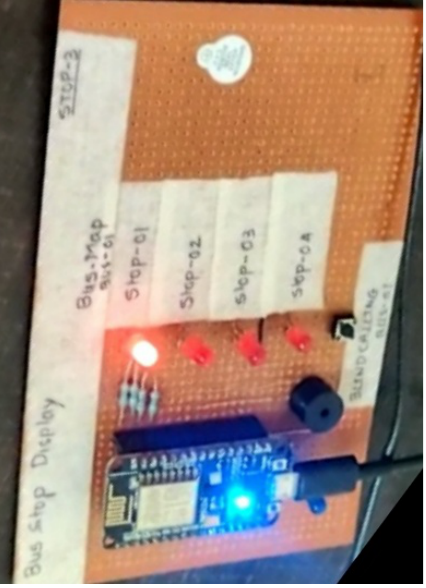
Figure 6. Implementation of the system near the BUS DEPOT